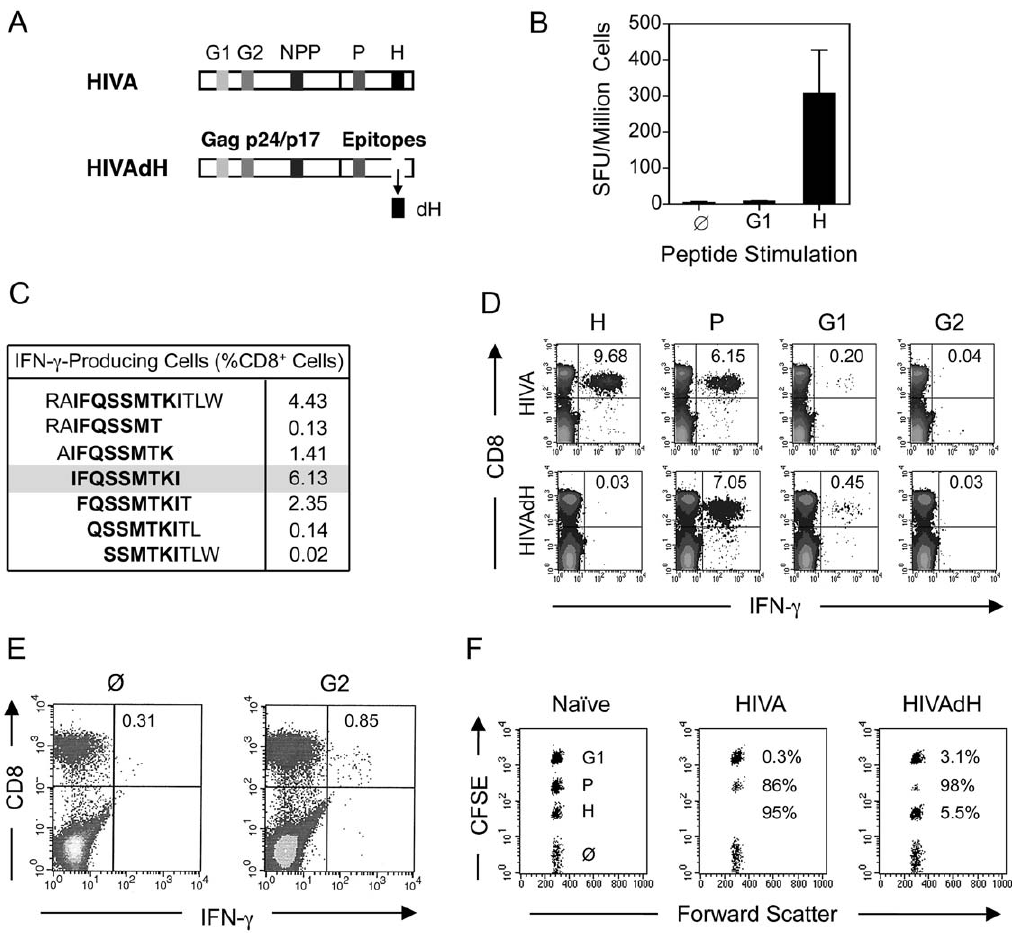
Figure 1. Enhancement of subdominant responses by deletion of immunodominant epitope. A) Schematic representation of the HIVA and HIVAdH immunogens depicting the locations of the H-2 d -restricted CD8 + T cell epitopes and deletion of epitope H. B) Immunogenicity of pTHr.HIVA DNA. A group of 4 BALB/c mice were immunized with a single dose of 100 m g of pTHr.HIVA DNA. Ten d later, splenocytes were isolated and assessed in an ex vivo IFN- c ELISPOT assay using the known G1 and H peptides. Responding cell frequencies are shown as mean 6 SD. C) Fine mapping of a previously unidentified CD8 + T cell epitope P. Groups of 4 BALB/c mice were primed with 50 m g of pTHr.HIVA DNA and boosted with 5 6 10 6 PFU of MVA.HIVA 2 wk later. Two wk after the boost, splenocytes were assessed in an ICS assay for IFN- c production using 14-mer and 6 staggered overlapping 9-mer peptides. D) Immunogenicity of HIVA and HIVAdH immunogens. Mice were immunized with immunogens HIVA or HIVAdH as described in C. Two wk after the boost, splenocytes were tested in an ICS assay for IFN- c production against the H, P, G1 and G2